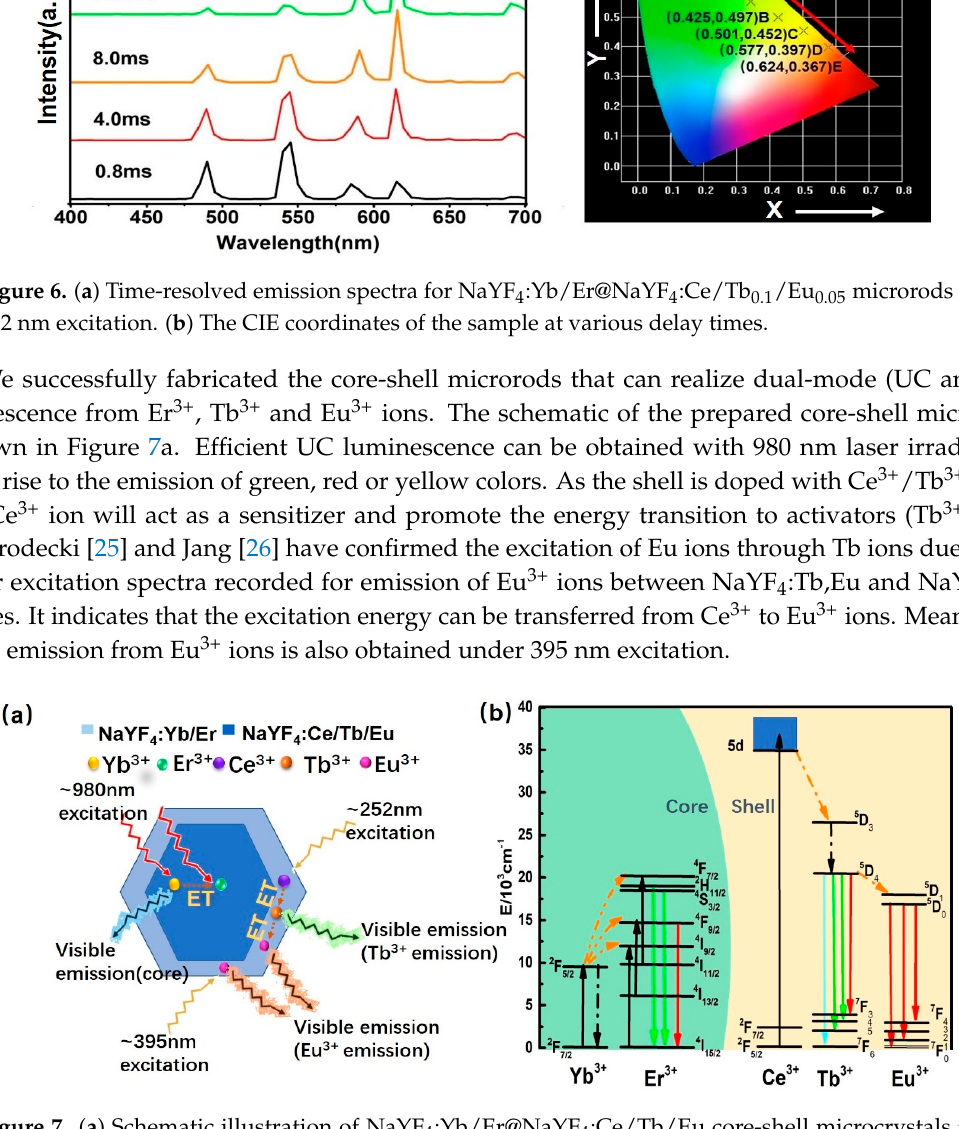
Figure 6. ( a ) Time-resolved emission spectra for NaYF 4 :Yb/Er@NaYF 4 :Ce/Tb 0.1 /Eu 0.05 microrods at 252 nm excitation. ( b ) The CIE coordinates of the sample at various delay times.